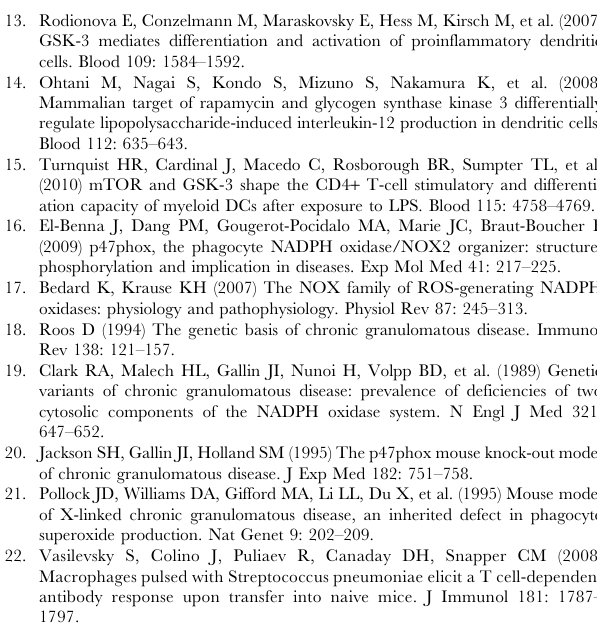
Figure S1 OT-II T lymphocyte stimulation. OT-II CD4 + T lymphocytes and OVA 323–339 -peptide-pulsed, IFN c /LPS ma- tured DC were co-cultured for 72 or 96 hours. T cell proliferation was determined by CFSE staining, the overall percentage of active cells was initially estimated by FSC v. SSC, the percentage of viable T cells was determined by positive staining for CD4 and PI exclusion (A) Representative flow cytometric analysis of 72 hour co-culture. (B) CFSE staining of proliferating OT-II lymphocytes (left 2 72 hours, right, 96 hours). (C) The levels of OT-II lymphocyte activation, viability and CD25/CD69 upregulation at 72 hours. The data are the mean ( 6 SEM) percentage for 3 individual experiments with 3–4 of each genotype/experiment. Figure S2 PCK inhibitor treatment. Supernatants from IFN c / LPS-stimulated DC treated, or not, with Bisindolylmaleimide or PKC e inhibtor peptide were harvested from overnight cultures and assayed for secreted IL-12p70. The data are the mean ( 6 SEM) for 3 individual experiments using pooled cells from 3–4 of each genotype/experiment with 2 6 10 5 DC/0.2 ml.